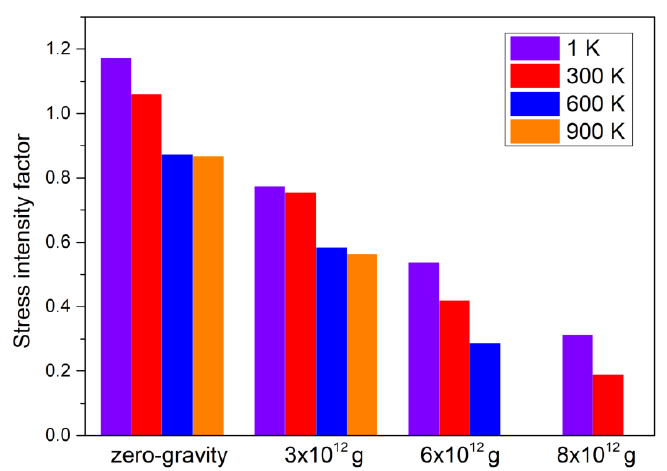
Figure 10. The stress intensity factor with the relation of the hyper − gravity intensity and tempera- ture.